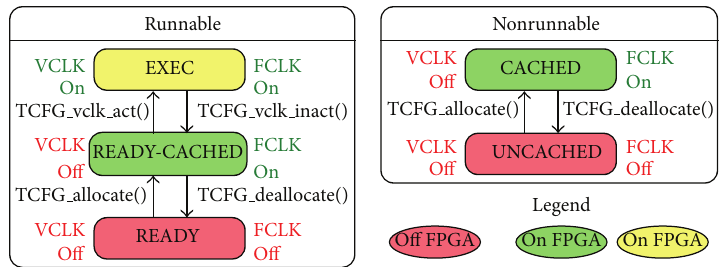
Figure 6: HWT State (HWT Scheduling and Placement Layer perspective).